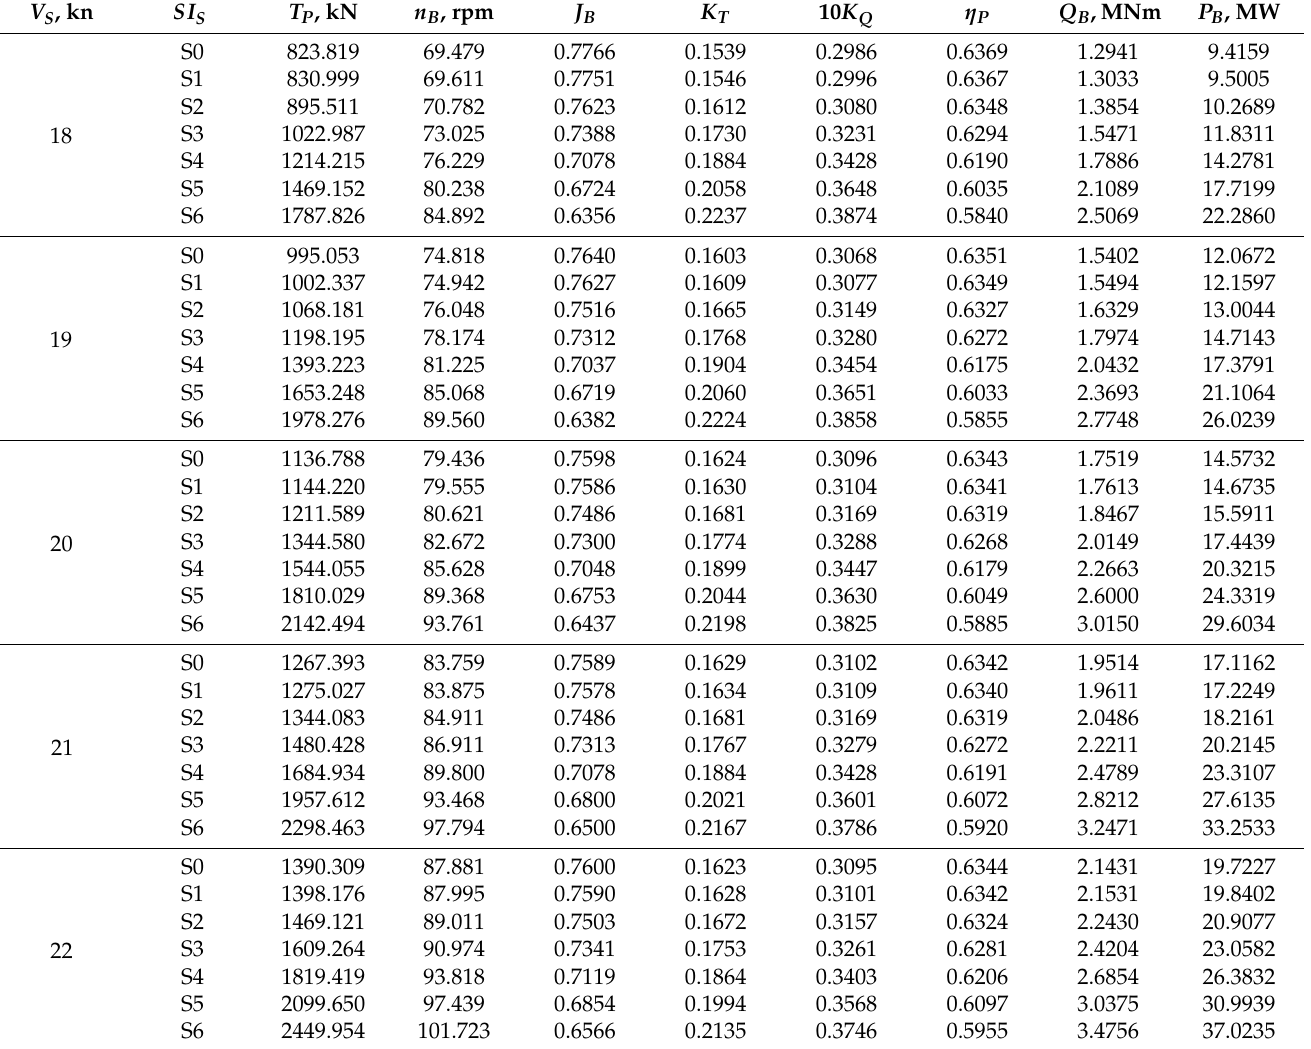
Table 5. Propulsion characteristics for various sailing speeds and sea